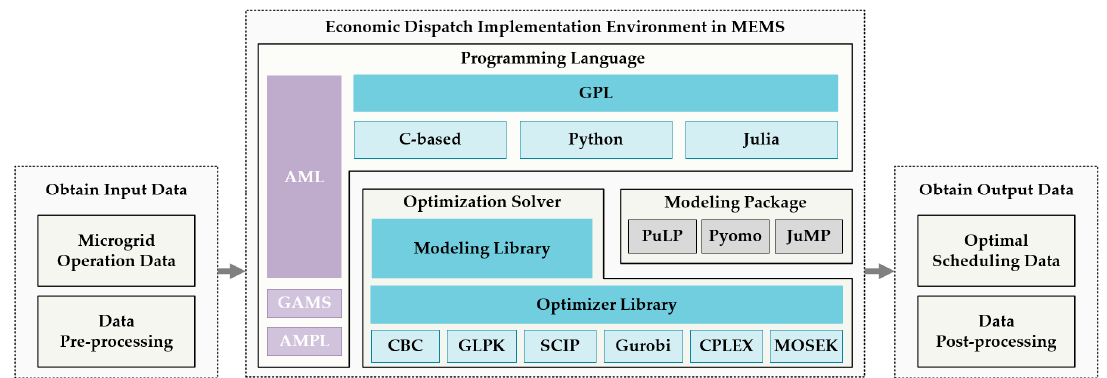
Figure 1. Overview of the economic dispatch (ED) implementation environment.